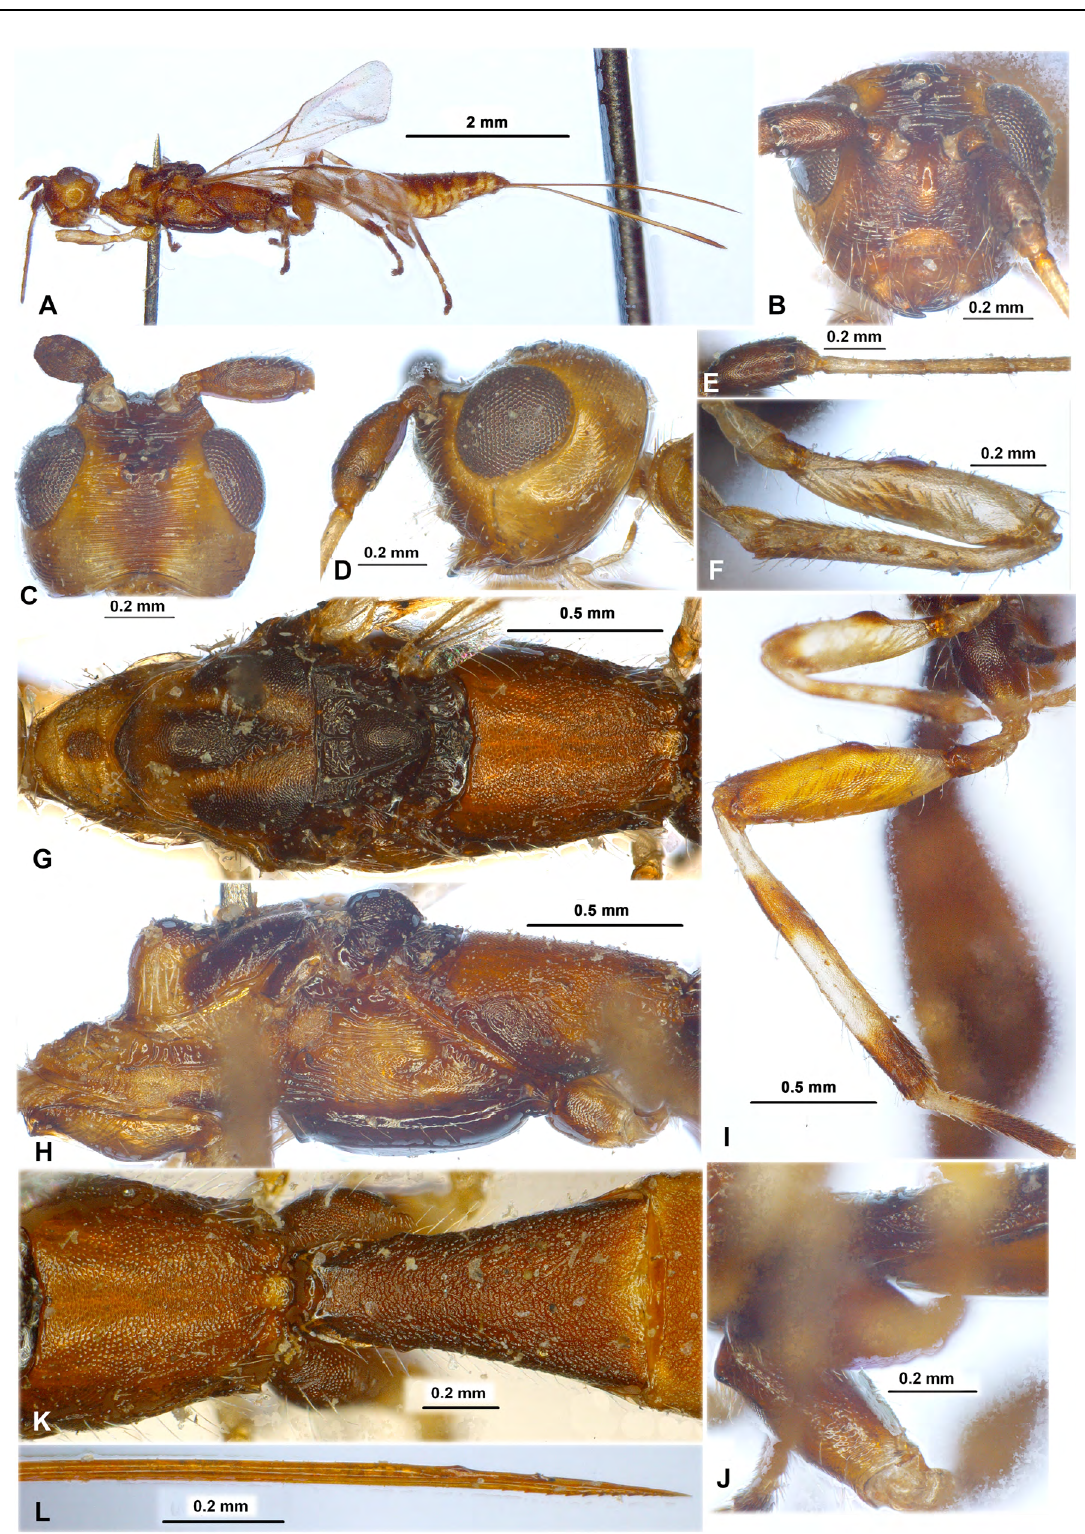
Fig. 36. Platyspathius ( Lenticularia ) lenticularis (Granger, 1949), ♀, holotype, MNHN. A . Habitus, lateral view. B . Head, front view. C . Head, dorsal view. D . Head, lateral view. E . Basal segments of antenna. F . Fore leg. G . Mesosoma, dorsal view. H . Mesosoma, lateral view. I . Hind leg. J . Hind coxa. K . Propodeum and first metasomal tergite, dorsal view. L . Apex of ovipositor, lateral